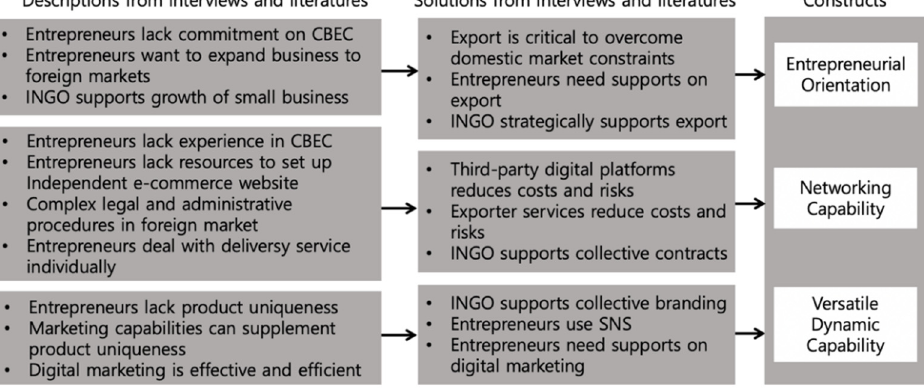
Figure 3. Data structure of interviews results and literatures.